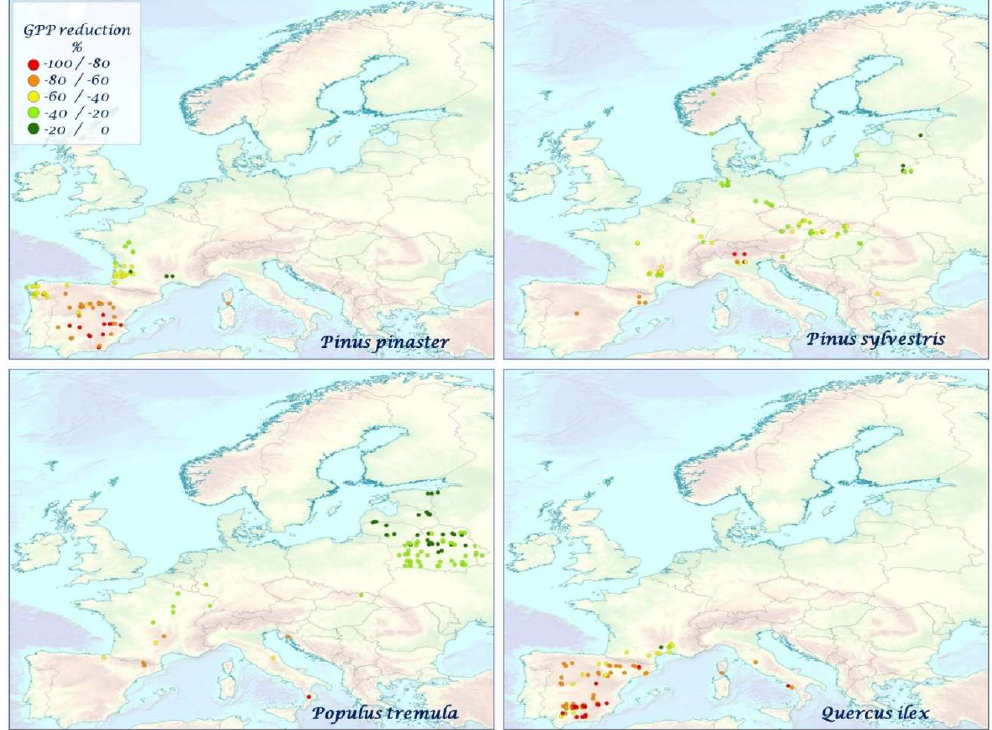
Figure 8. The mean species–specific GPP reduction (%) for P. pinaster, P. sylvestris, P. tremula, Q. ilex over the time period 2000–2010.